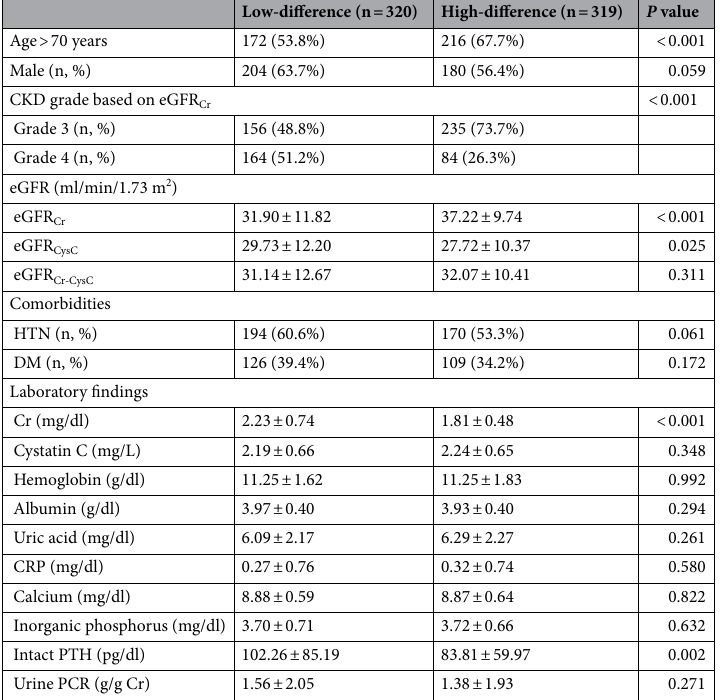
Table 1. Comparison of the baseline characteristics between the low- and high-difference groups. Continuous variables are expressed as the mean ± standard deviation. Categorical variables are expressed as numbers (percentages). Ca Calcium, CKD Chronic kidney disease, Cr Creatinine, CRP C-reactive protein, DM Diabetes mellitus, eGFR Estimated glomerular filtration rate, eGFR Cr eGFR based on creatinine, eGFR CysC eGFR based on cystatin C, eGFR Cr-CysC eGFR based on both creatinine and cystatin C, HTN Hypertension, PCR Protein/ creatinine ratio, PTH Parathyroid